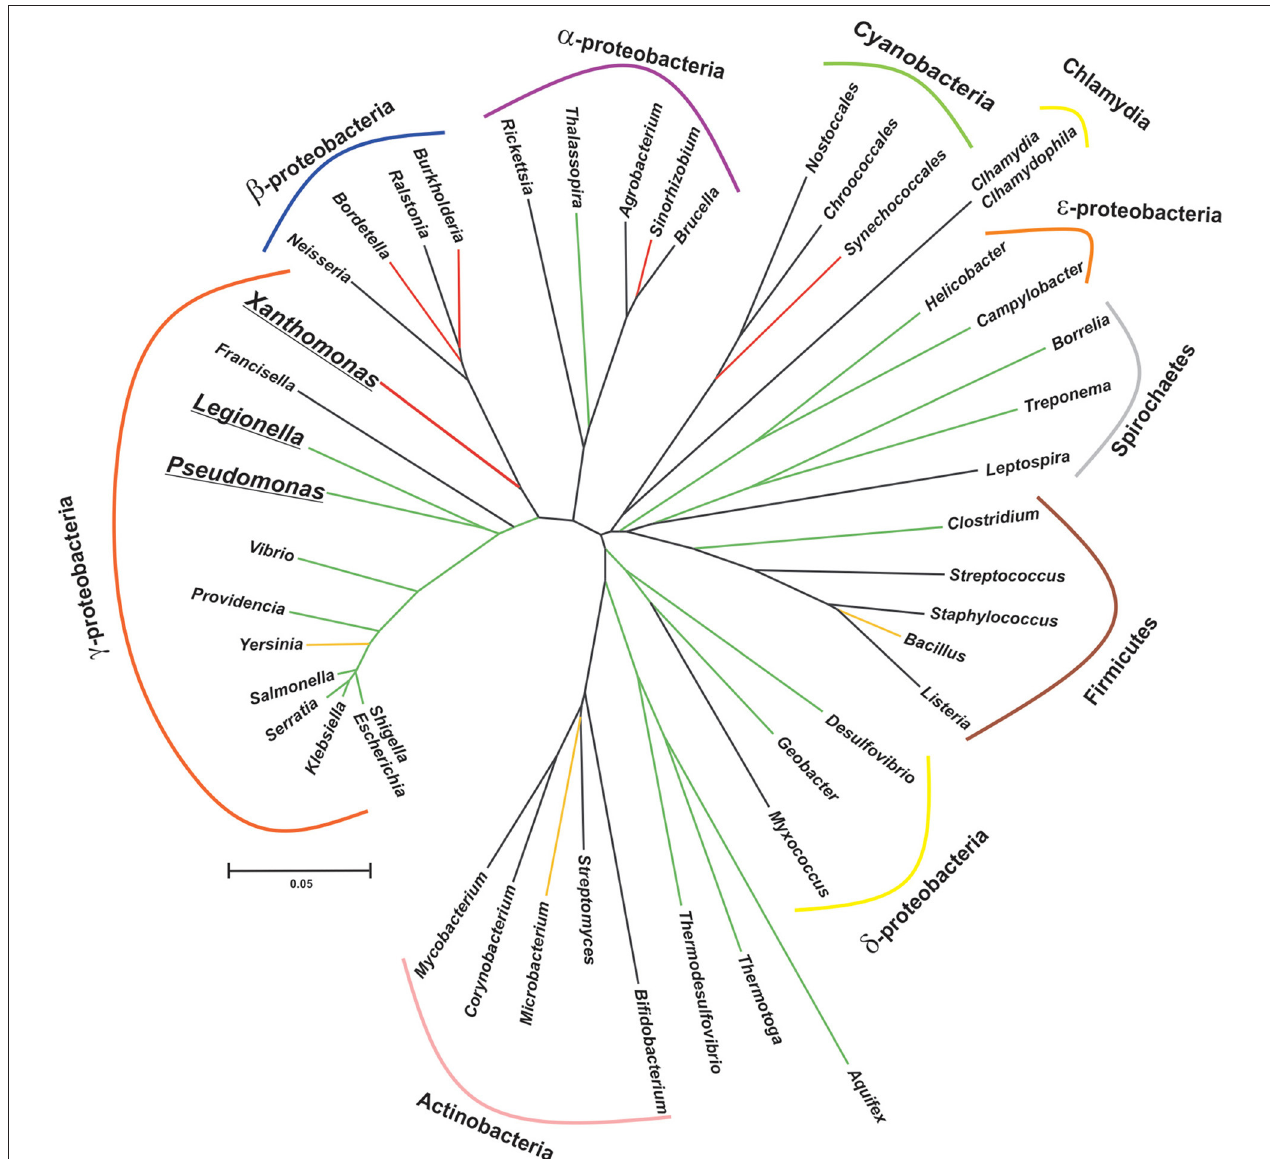
FIGURE 1 | Patched phylogenetic distribution of genes encoding CsrA homologs in major eubacterial taxa. The phylogenetic tree was generated on the basis of the 16S rDNA sequences of one representative species for each eubacterial genus present in the diagram. The evolutionary history was inferred using the Neighbor-Joining method (Saitou and Nei, 1987). The optimal tree with the sum of branch length = 3.385 is shown. The tree is drawn to scale, with branch lengths in the same units as those of the evolutionary distances used to infer the phylogenetic tree. The evolutionary distances were computed using the Kimura 2-parameter method (Kimura, 1980) and are in the units of the number of base substitutions per site. This analysis involved 46 nucleotide sequences. All positions with < 95% site coverage were eliminated, i.e., fewer than 5% alignment gaps, missing data, and ambiguous bases were allowed at any position (partial deletion option). There were a total of 1,174 positions in the final dataset. Evolutionary analyses were conducted in MEGA X (Kumar et al., 2018). The reference bar length indicates the number of nucleotide substitution per site. The branch color corresponds to the proportion of species per class that contain at least one csrA allele, as follows: black, 0% (no homologs in this class); red, < 10%; yellow, > 50%; green, 100%. Bolded and underlined taxon names denote those genera which present more than one allele per